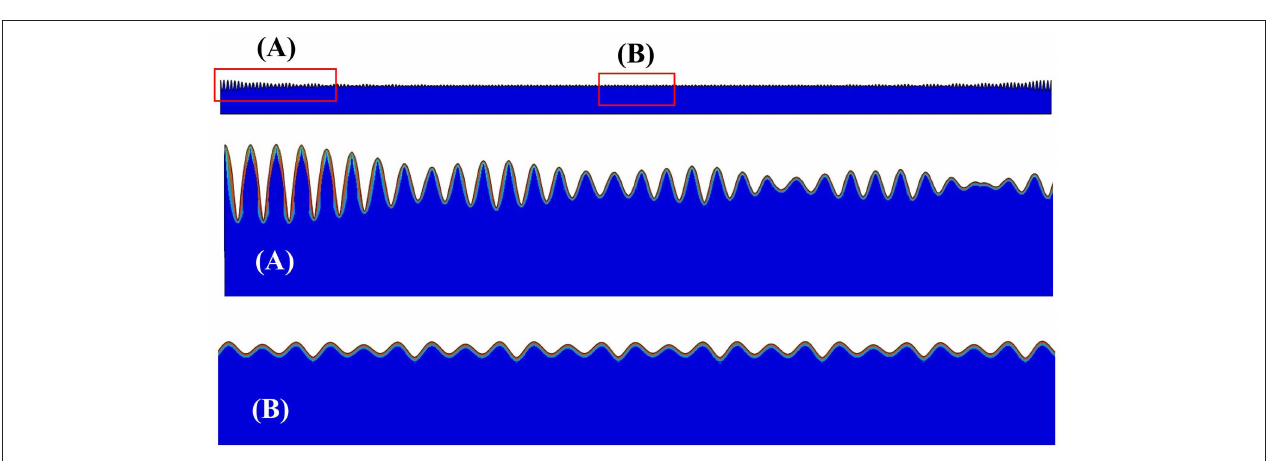
Frontiers in Materials |